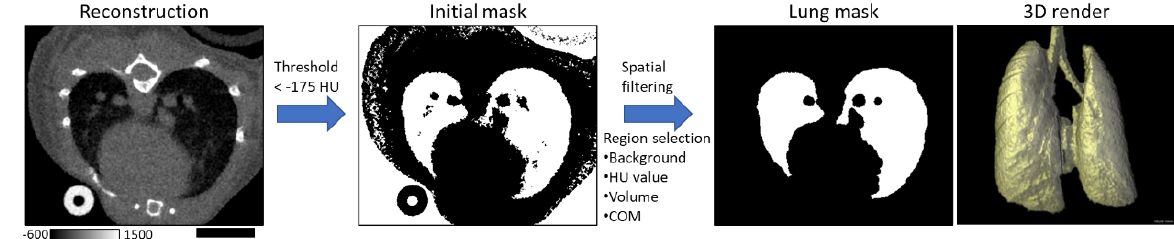
Figure 1. Stages of lung mask creation. The original image is thresholded to separate dense tissues from air and lungs. The resulting initial mask image is then morphologically filtered and continuous regions are sorted to identify the lung mask.